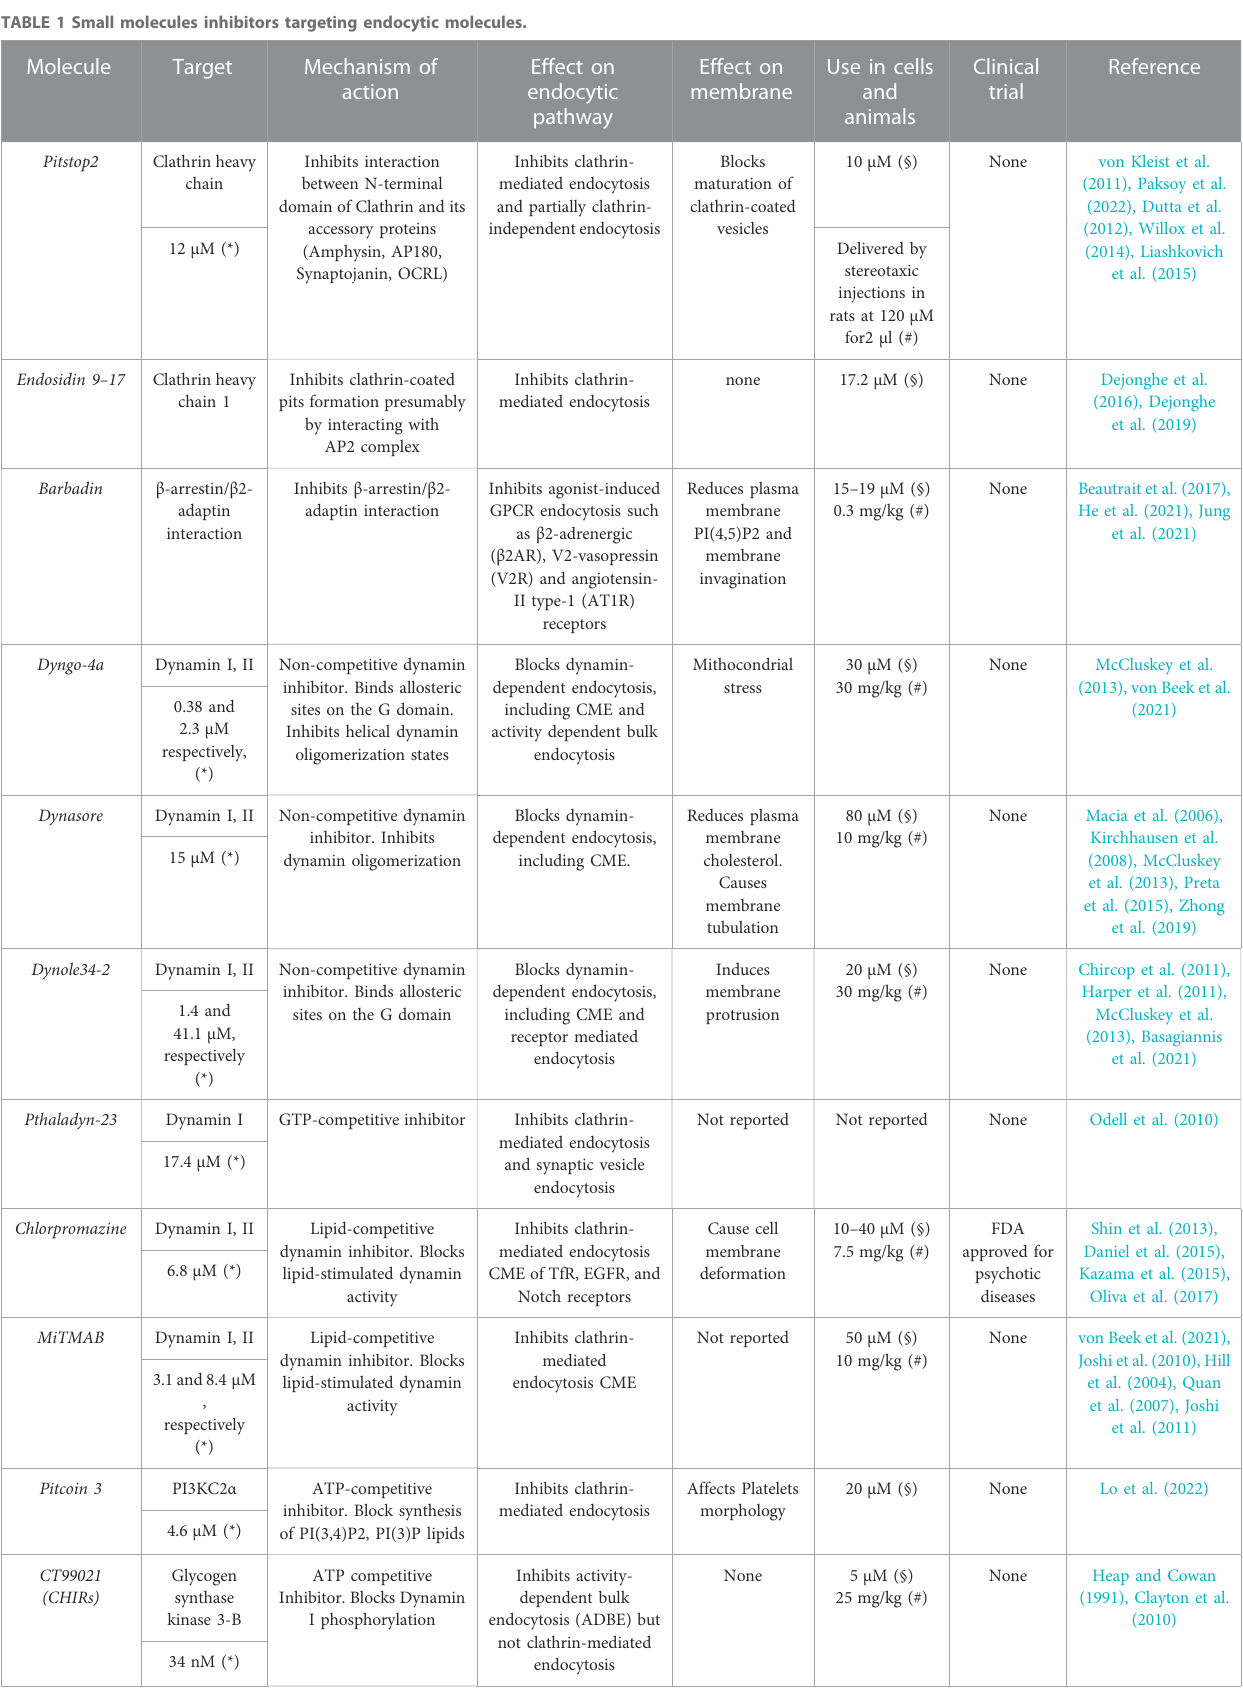
TABLE 1 Small molecules inhibitors targeting endocytic